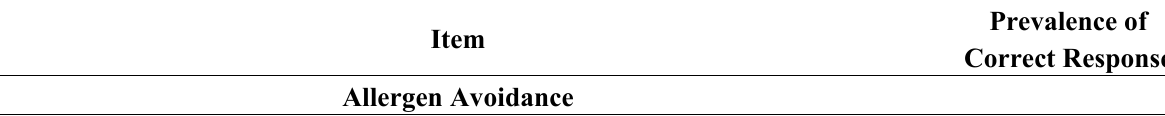
Table 2. Food allergy knowledge strengths.